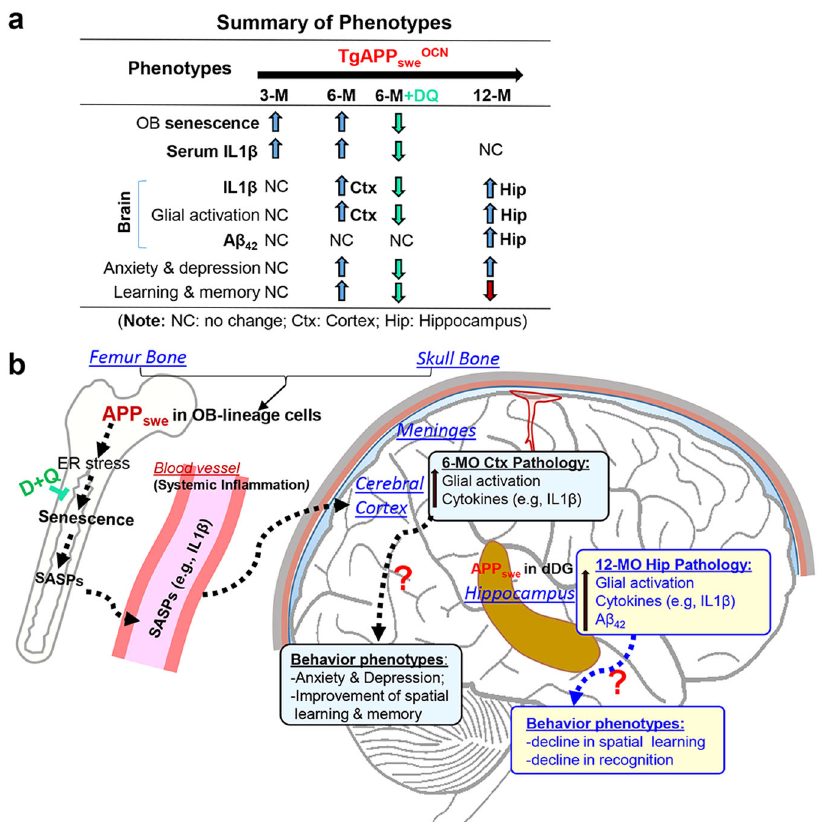
Fig. 10 Summary and working hypothesis for APP swe in OB-lineage cells to regulate brain-pathology and behavior changes. a Summary of phenotypes detected in TgAPP swe OCN mice at indicated ages. b Illustration of the working Fig. 10b, and opens a box of additional questions for future investigations.